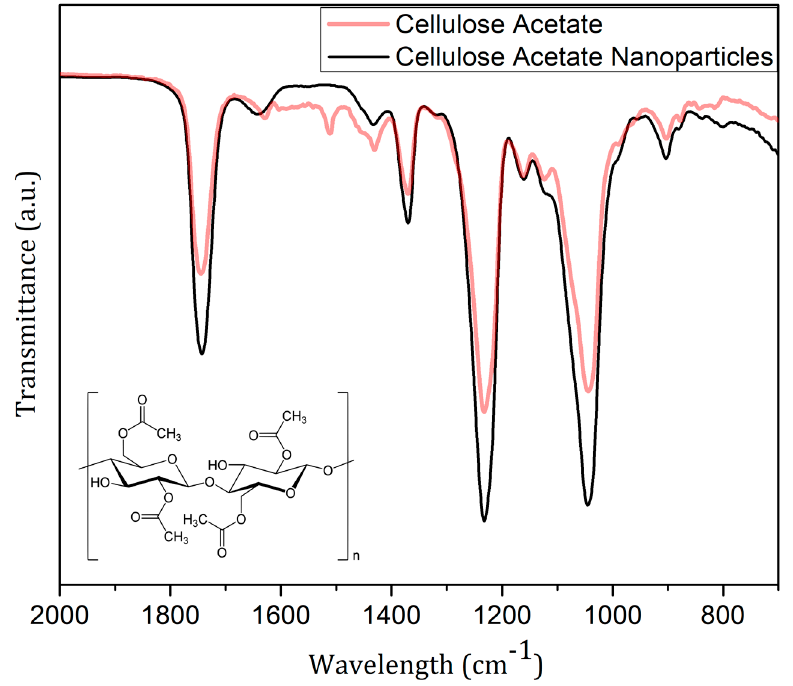
Figure 3. FTIR spectra of cellulose acetate nanoparticles (CA-NPs) (black line); cellulose acetate from Sigma-Aldrich (red line); and cellulose acetate chemical structure in detail.